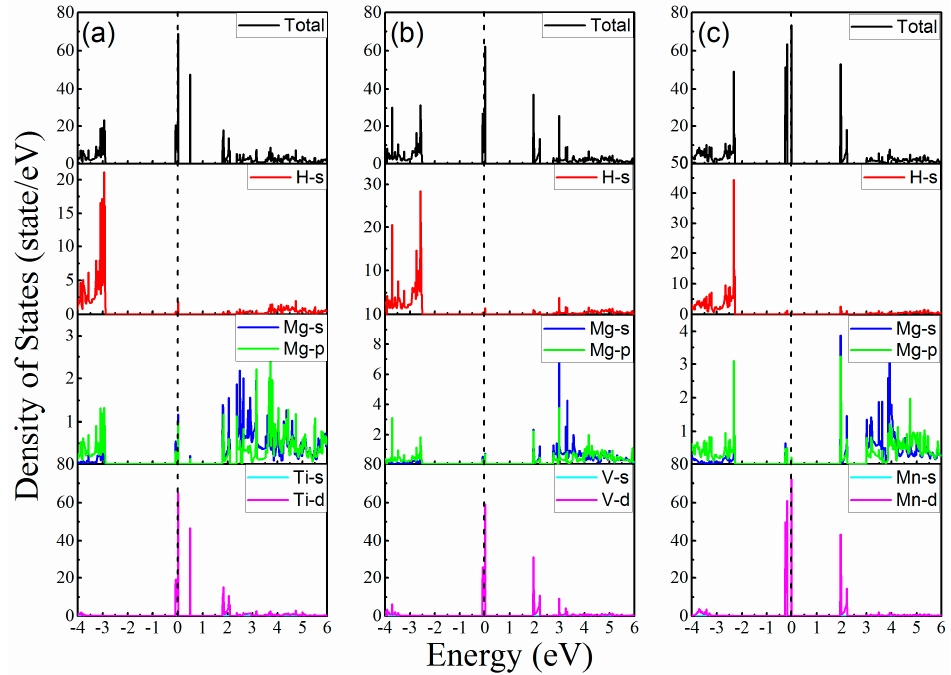
Figure 4. The total and partial densities of states of Mg 8 H 18 Ti ( a ); Mg 8 H 18 V ( b ); and Mg 8 H 18 Mn ( c ).